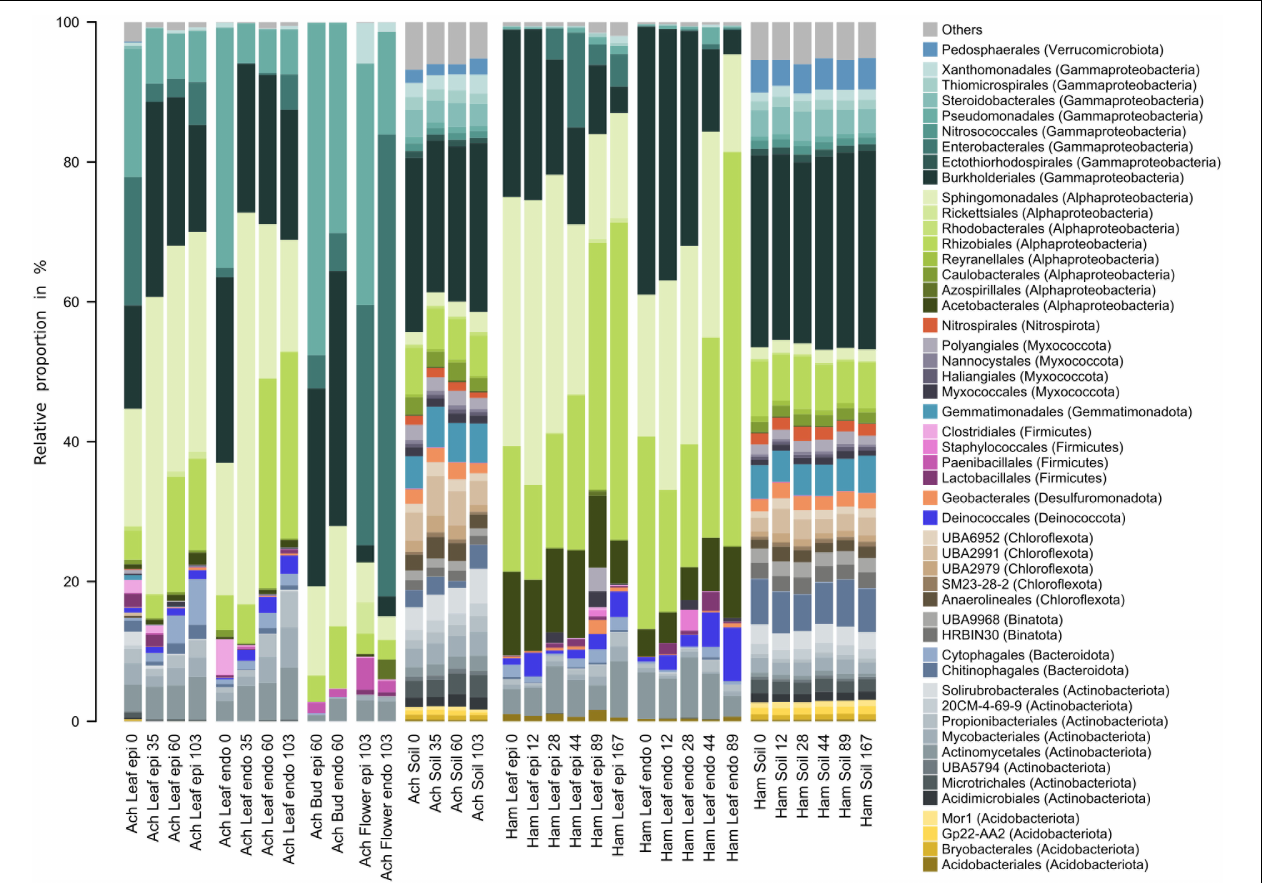
FIGURE 6 | Relative proportions of the 50 most abundant bacterial orders of the epi- and endophytic leaf, bud, flower and soil communities of Achillea (Ach) over a period of 103 days (April to July) and of the epi- and endophytic leaf and soil communities of Hamamelis (Ham) over periods of 89 and 167 days (April to July and September),